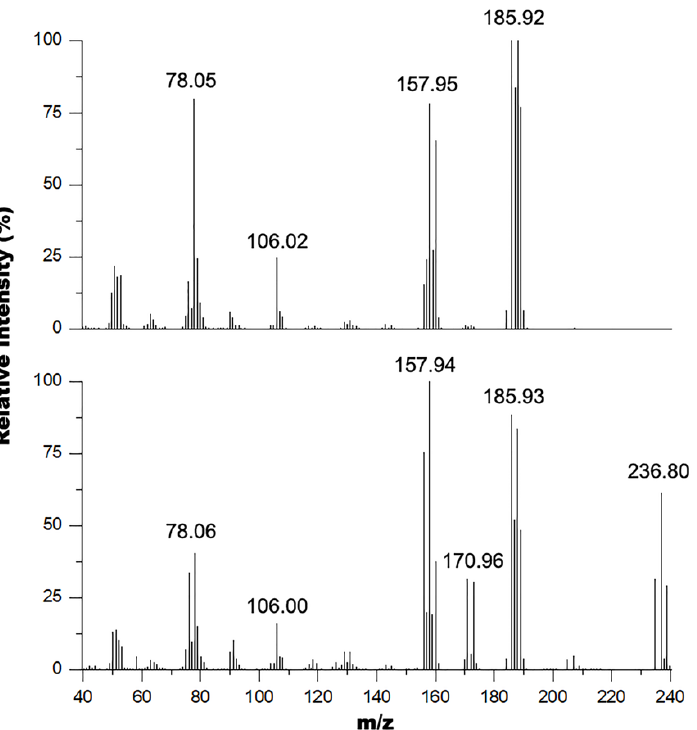
Figure 3. Overlay of the mass spectra of the pure oil ( top ) and oil mixture with solid ( bottom Figure 3 . Overlay of the mass spectra of the pure oil (top) and oil mixture with solid (bottom) .